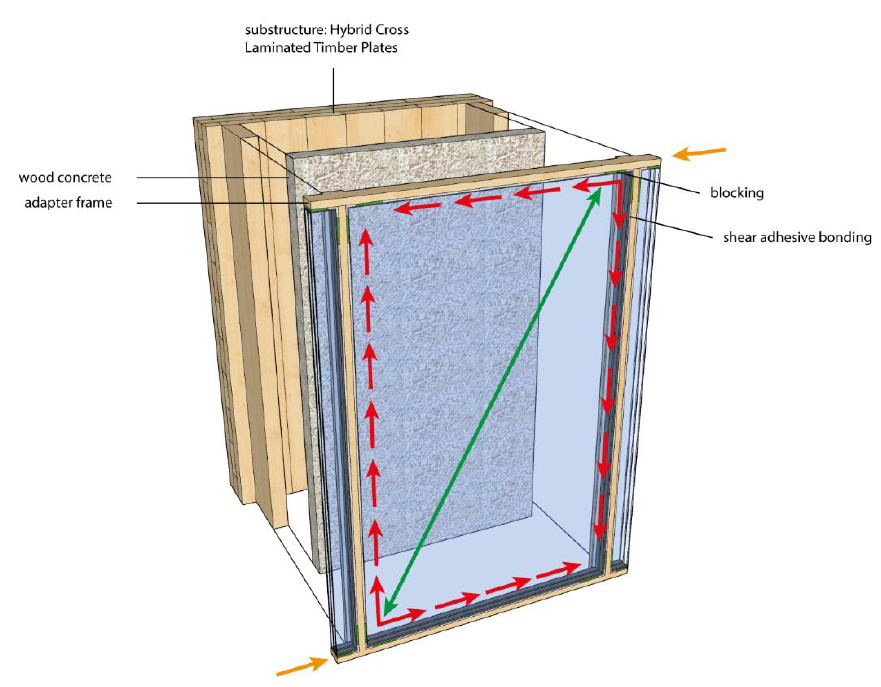
Fig. 1 Basic idea of the combination of timber-wood concrete-glass